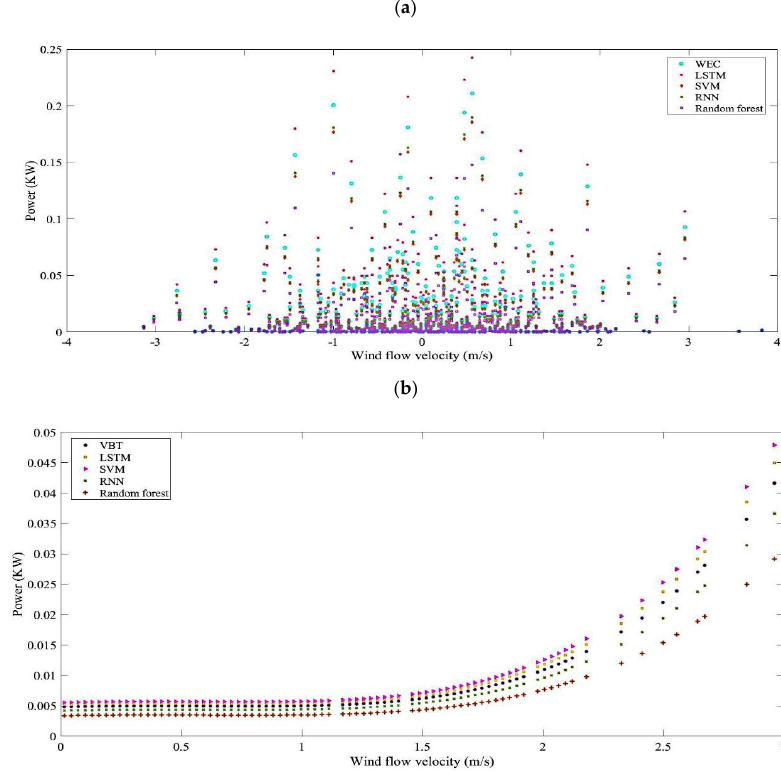
Figure 4. Power produced over 50 s of simulation for ( a ) VBT and ( b ) WEC.